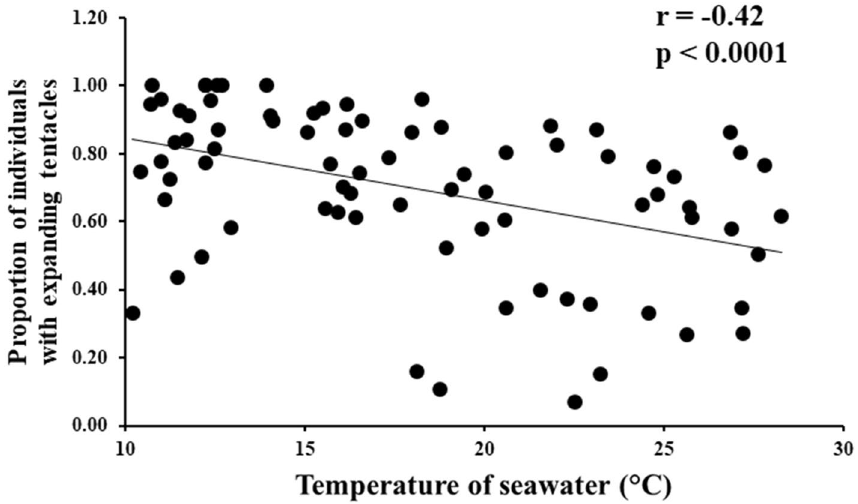
Figure 6. The relationship between the proportion of individuals with expanding tentacles from their inhabited tubes and seawater temperature.